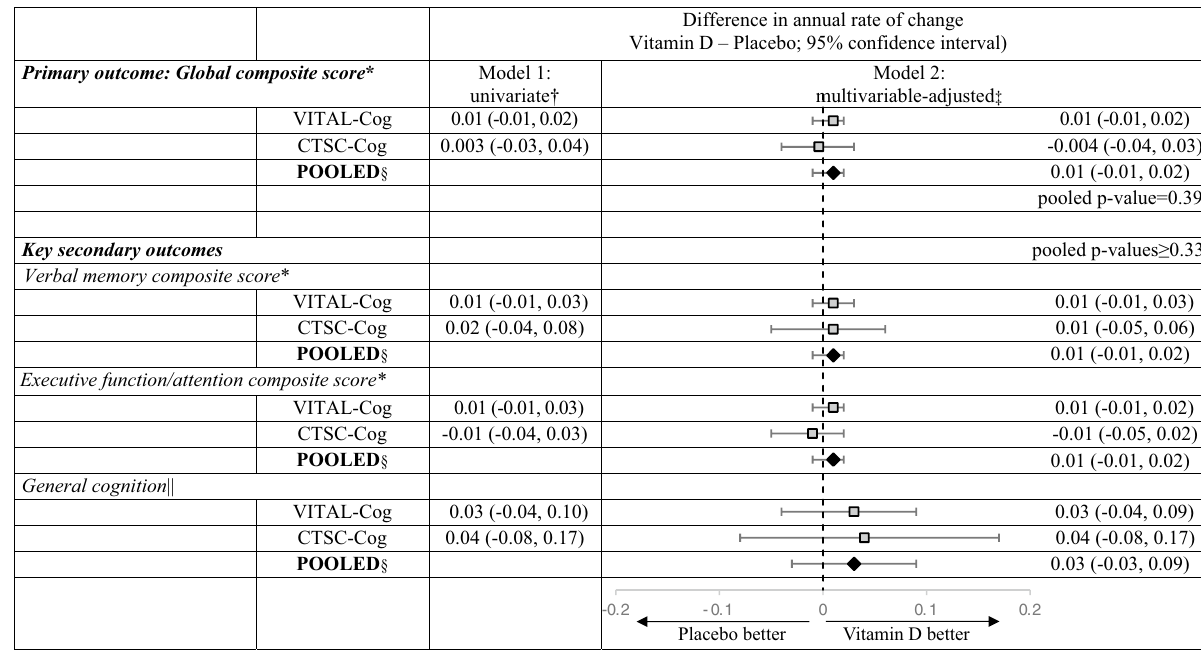
Table 3. Meta-analysis of the mean differences (95% CI) in change over time among VITAL-Cog participants (n = 3424) and CTSC-Cog participants (n = 794), by Vitamin D supplement assignment. 3MS Modified